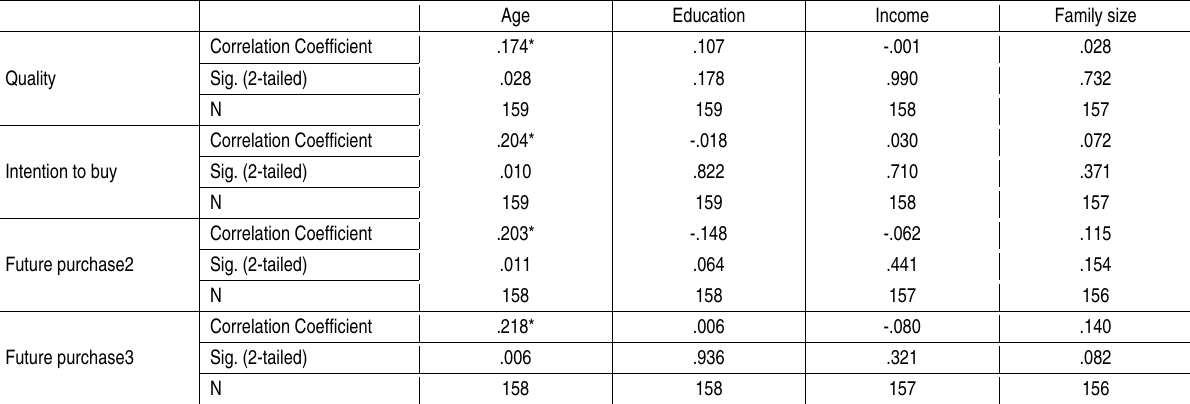
Table 2. Correlation between drivers and demographic